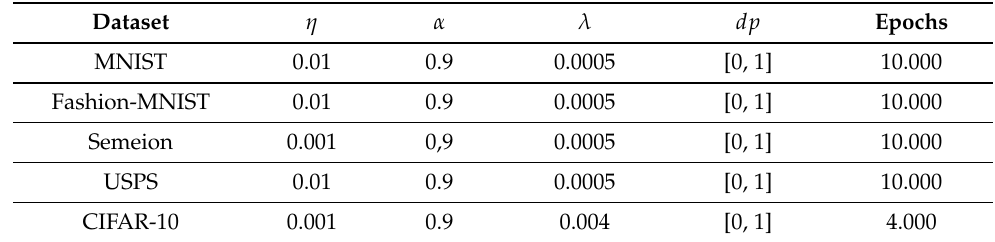
Table 16. Employed CNNs parameters summary.